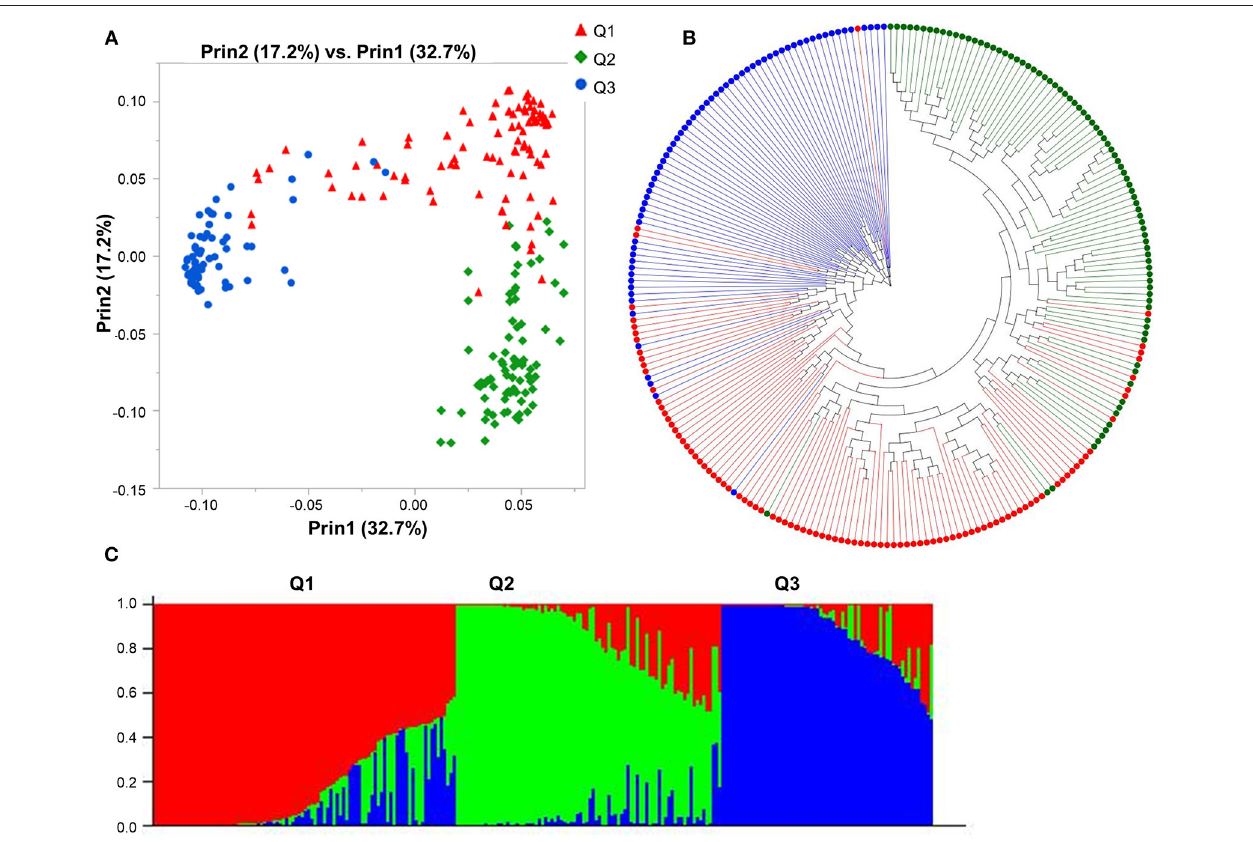
FIGURE 1 | Model-based populations of spring barley collection: (A) Two-dimension distribution analyzed by principal component analysis (PCA) by JMP Genomics 9.1, (B) phylogenetic tree constructed by neighbor-joining (NJ) of genetic distance by TASSEL 5.2.28, and (C) Classification of three populations using STRUCTURE 2.3.4. The color code indicates the distribution of the accessions to different populations (Q1: red, Q2: green, Q3: blue) consistent in (A–C) .